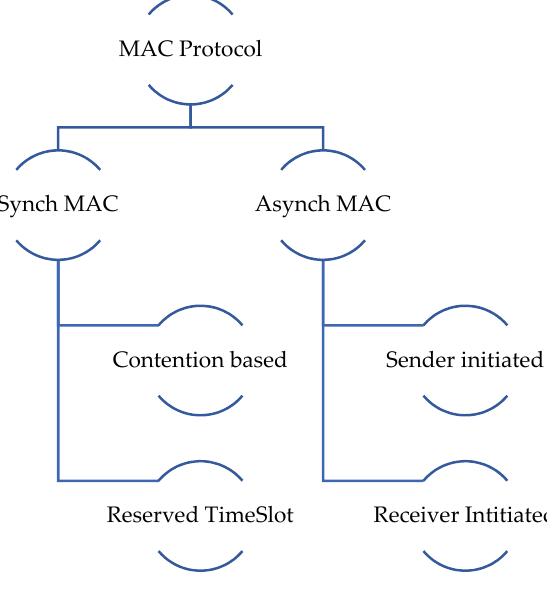
Figure 2. Classification of MAC protocols.